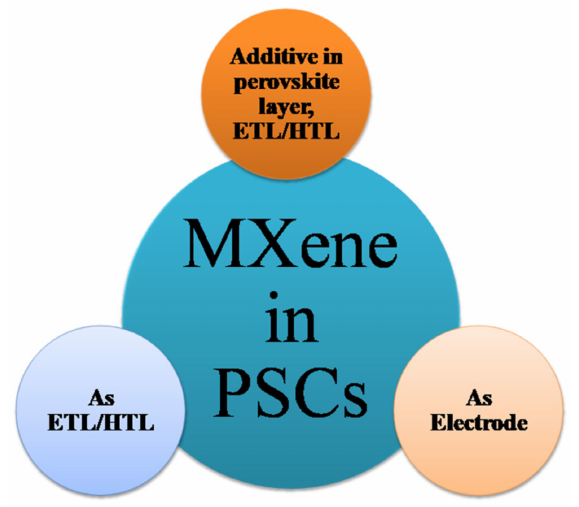
Figure 1. Incorporation of MXene in